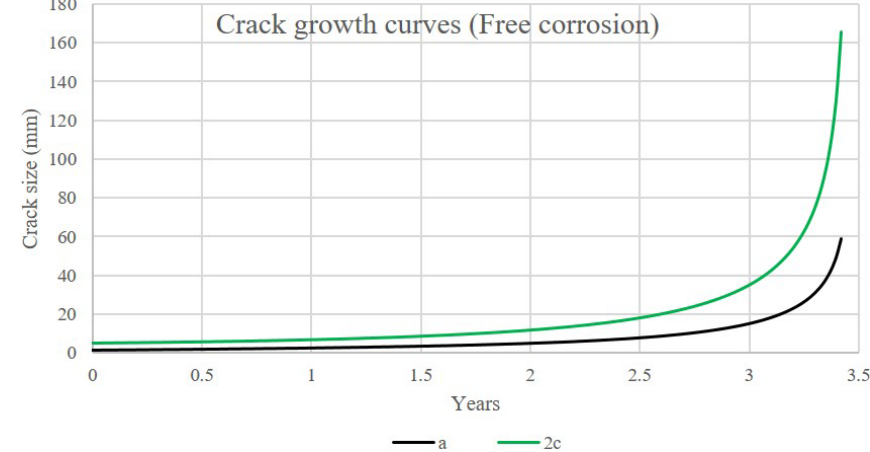
Figure 25. Crack growth curves for propagation in HAZ and with free